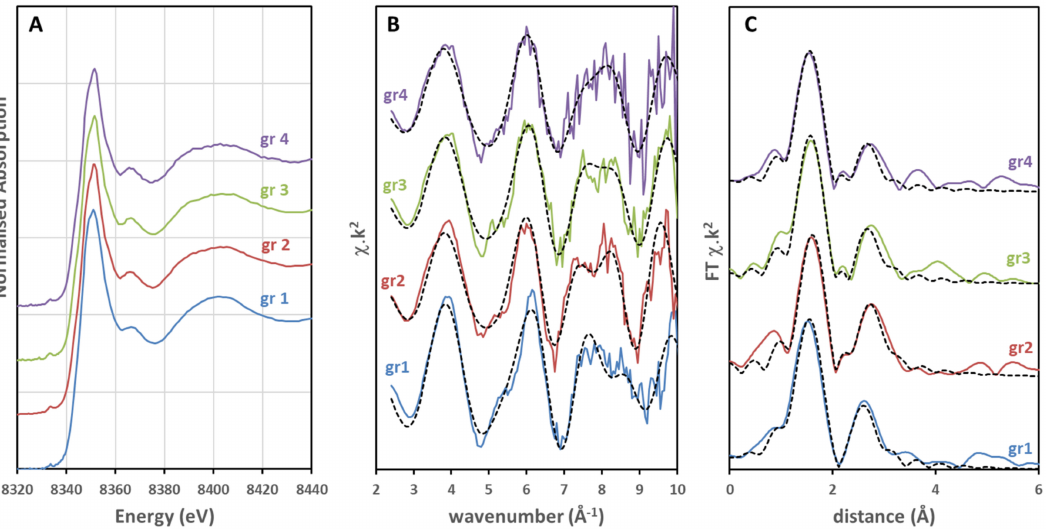
Figure 18. ( A ) Ni K-edge XANES spectra of 4 asbolane-lithiophorite intermediate grains from sample F033. ( B ) EXAFS spectra for the same asbolane-lithiophorite intermediates points as shown in ( A ). ( C ) Fourier transforms of the Ni EXAFS spectra from ( B ). Dashed lines in ( B ) and ( C ) are the modelled fits to the experimental data (solid